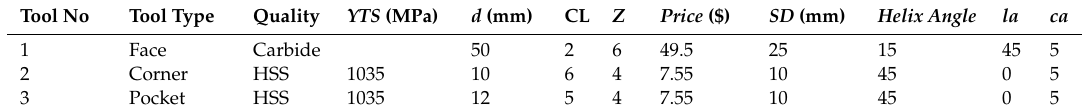
Table 4. Tools data for case study [14].